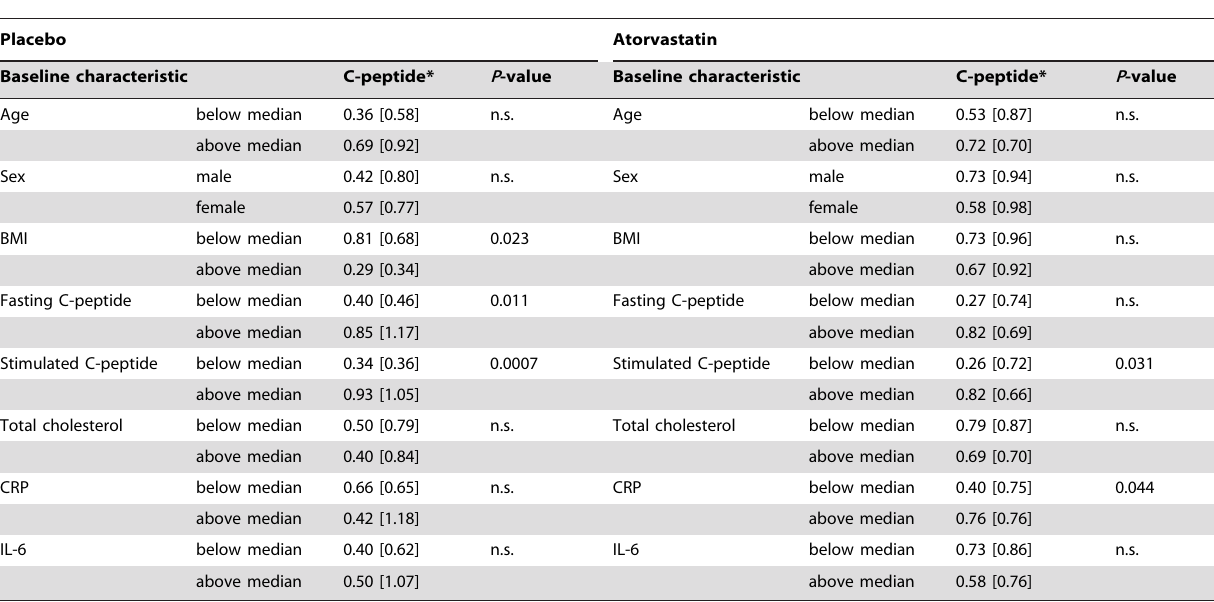
Table 1. Baseline characteristics of patients versus